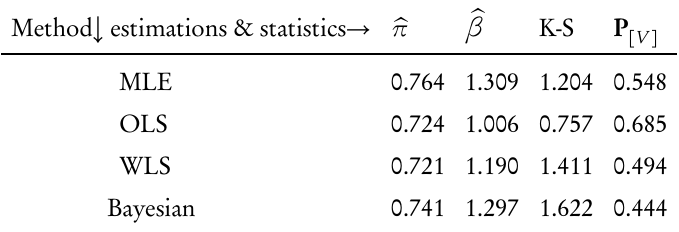
Comparing methods under carious teeth data.